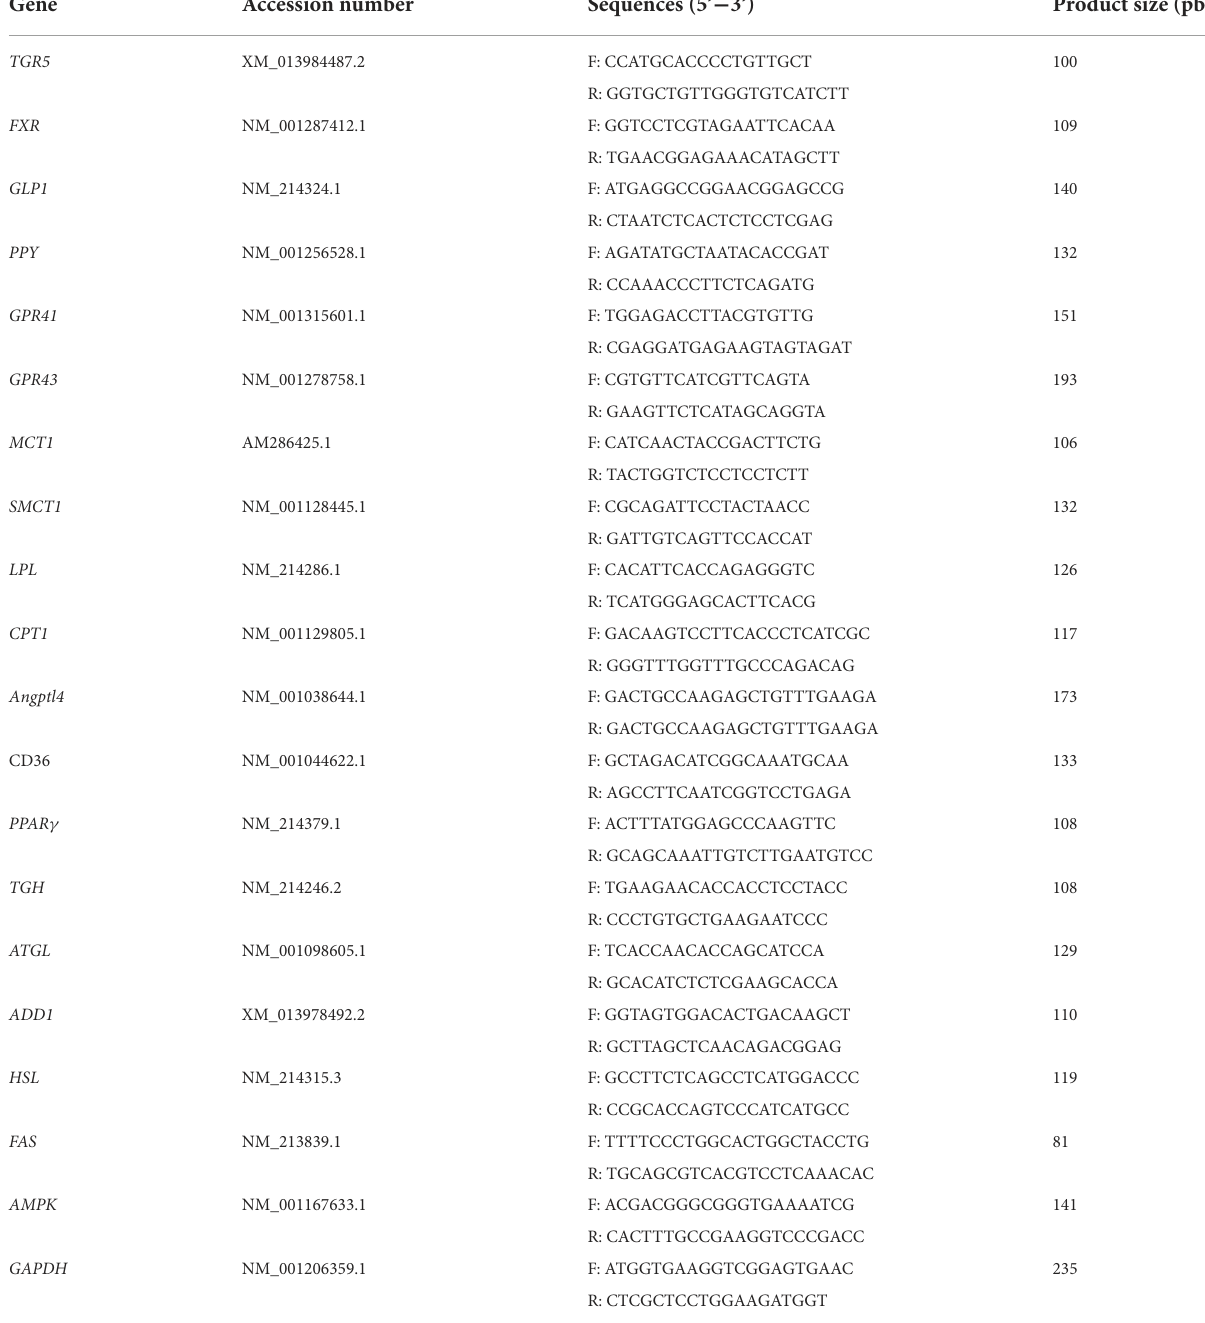
TABLE 2 Primers for target